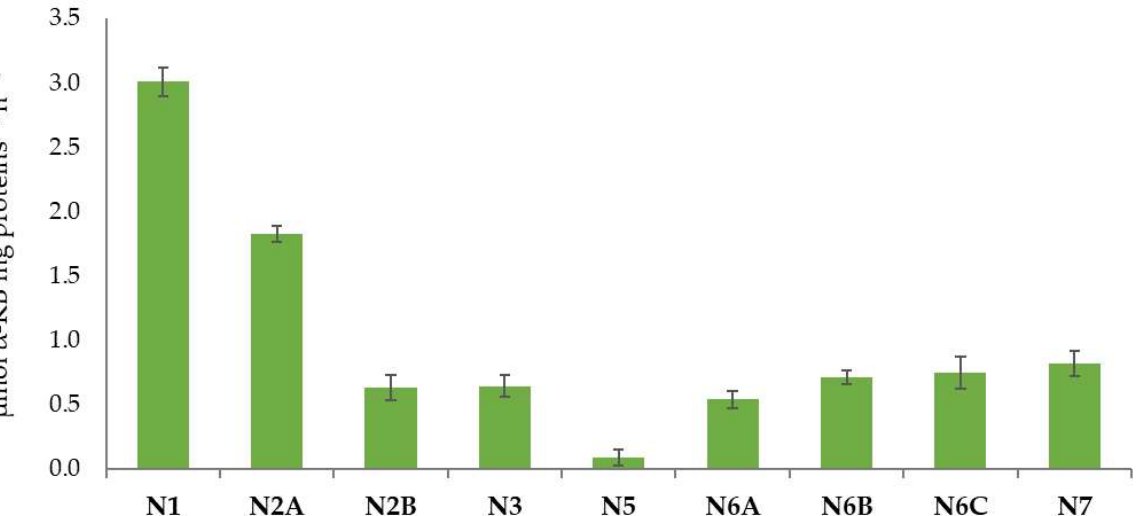
Figure 8. The 1-aminocyclopropane-1-carboxylate (ACC) deaminase activity (µmol α-KB mg proteins −1 h −1 ) expressed by the isolated strains.